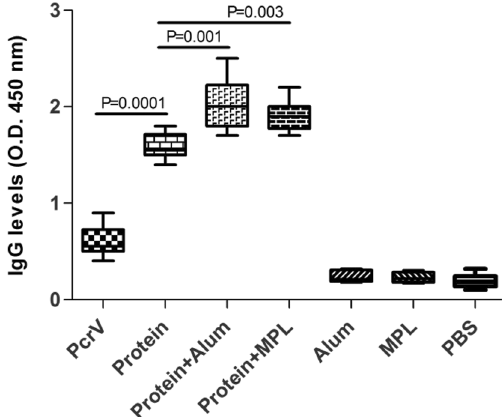
Figure 1. Measurement of serum IgG responses. Mice were vaccinated subcutaneously three times with PcrV alone, hybrid protein alone (protein), hybrid protein admixed with alum (Protein + Alum), hybrid protein admixed with MPL (Protein + MPL). The control groups were given Alum, MPL, and PBS. Blood samples were collected and anti-hybrid protein IgG levels were measured by ELISA. Significant values are shown with P value. Data are shown as mean ± SD of three independent experiments at dilution